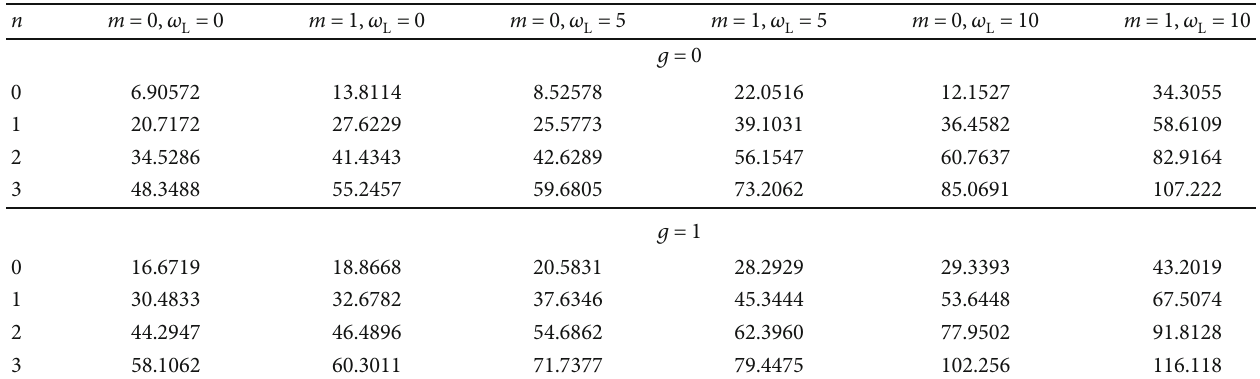
Table 3: Energy spectra for CO molecules bounded by the isotropic oscillator plus inverse quadratic potential for arbitrary Larmor frequencies ω . L :